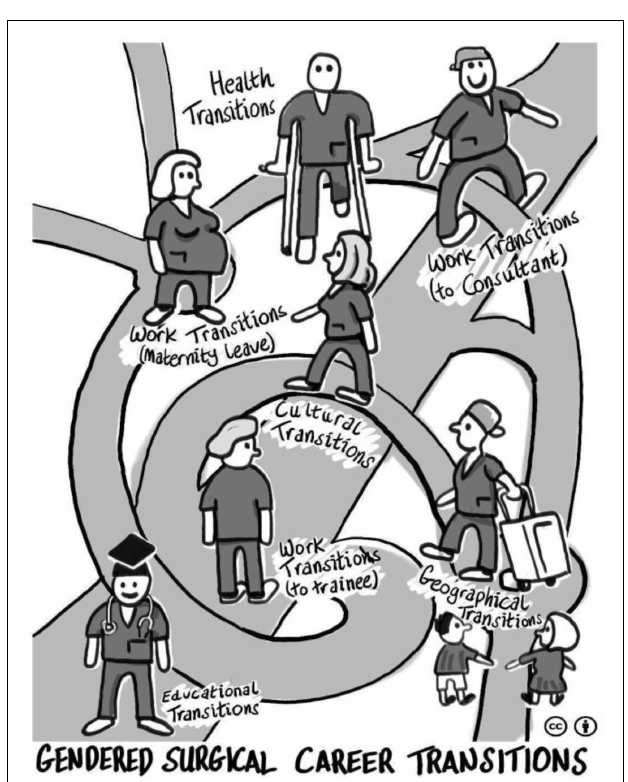
FIGURE 1 | Illustration of multiple